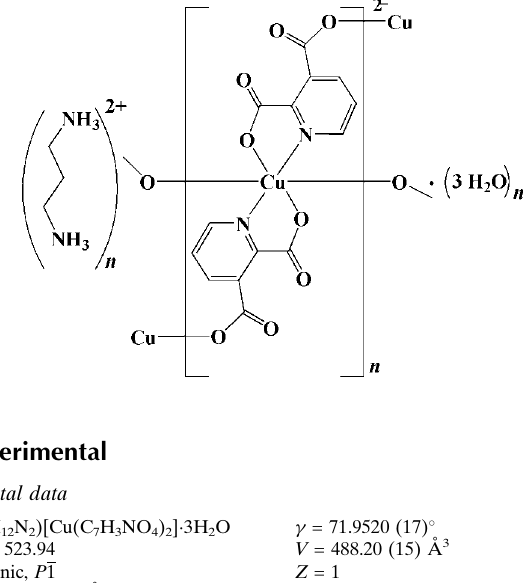
Bruker SMART APEXII CCD diffractometer Absorption correction: multi-scan ( SADABS ; Sheldrick, 2003) T min = 0.775, T max = 0.836